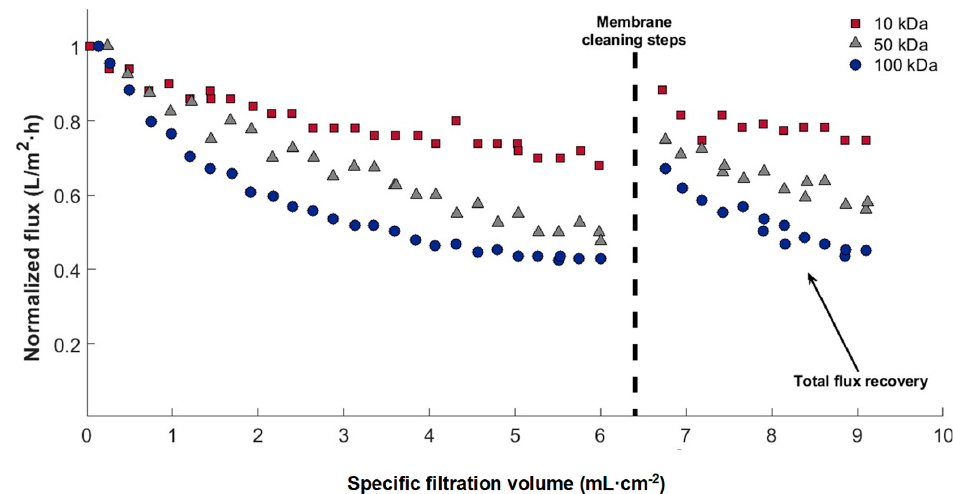
Figure 3. Flux vs. permeate volume, during filtration of PMTE using 10 kDa, 50 kDa, and 100 kDa ultrafiltration-polyethersulfone (UF-PES) membranes. The applied transmembrane pressure was 2.0 bar, at room temperature, and the total organic carbon (TOC) concentration of the feed solution was about 78.0 ± 2.5 mg · L − 1 .